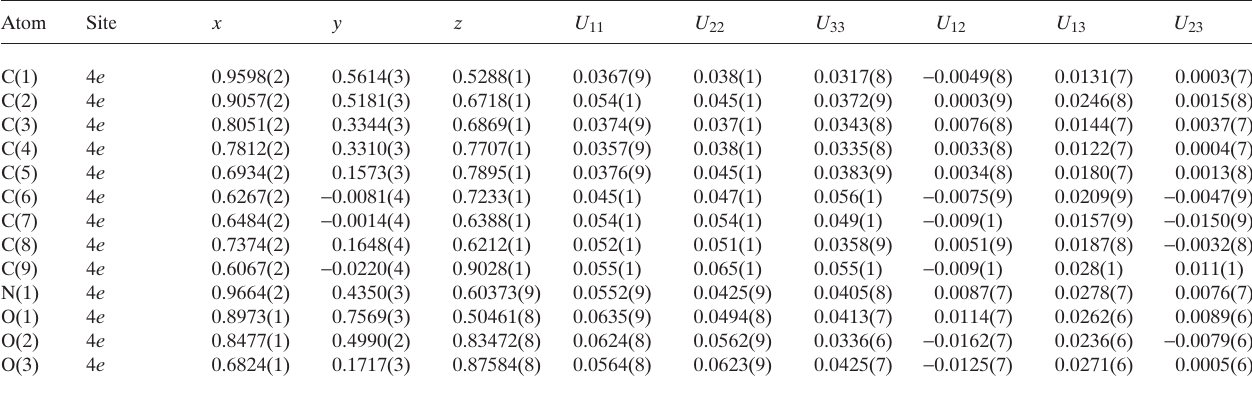
Table 3. Atomic coordinates and displacement parameters (in Å 2 )